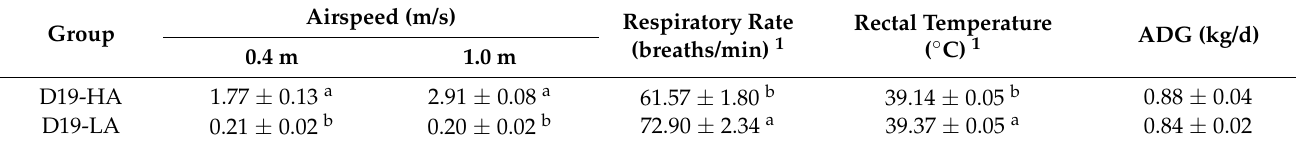
Table 5. Airspeeds, respiratory rates, rectal temperatures, and ADG (mean ± SEM) of calves of groups D19-HA and D19-LA. Group